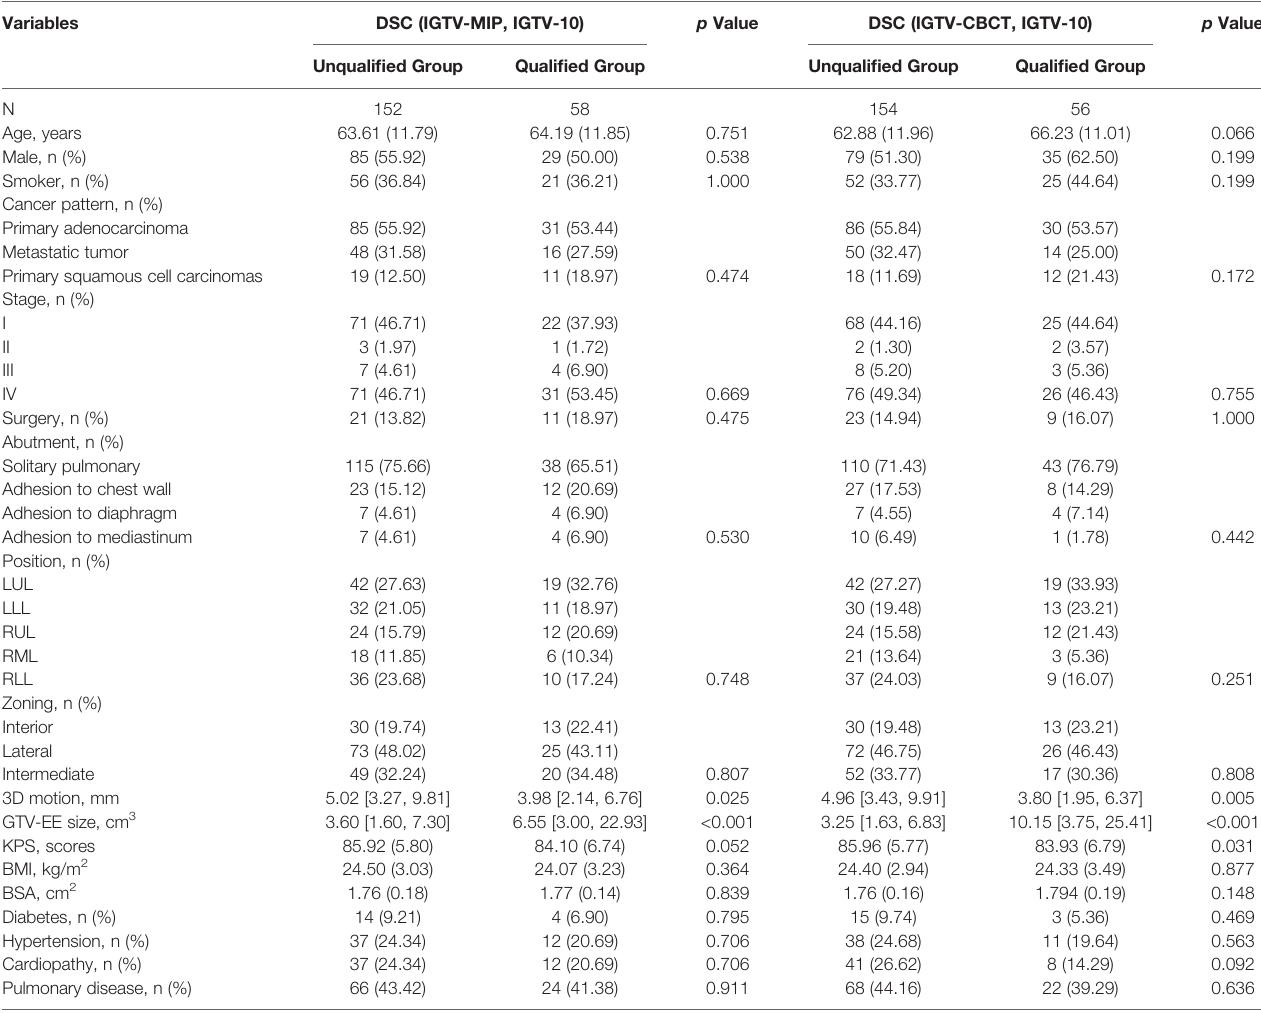
TABLE 1 | Baseline Characteristics by DSC (IGTV-MIP, IGTV-10) and DSC (IGTV-CBCT, IGTV-10).